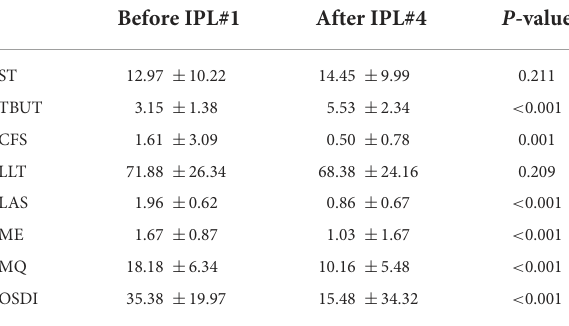
TABLE 2 Summary of the findings obtained before and after intense pulsed light